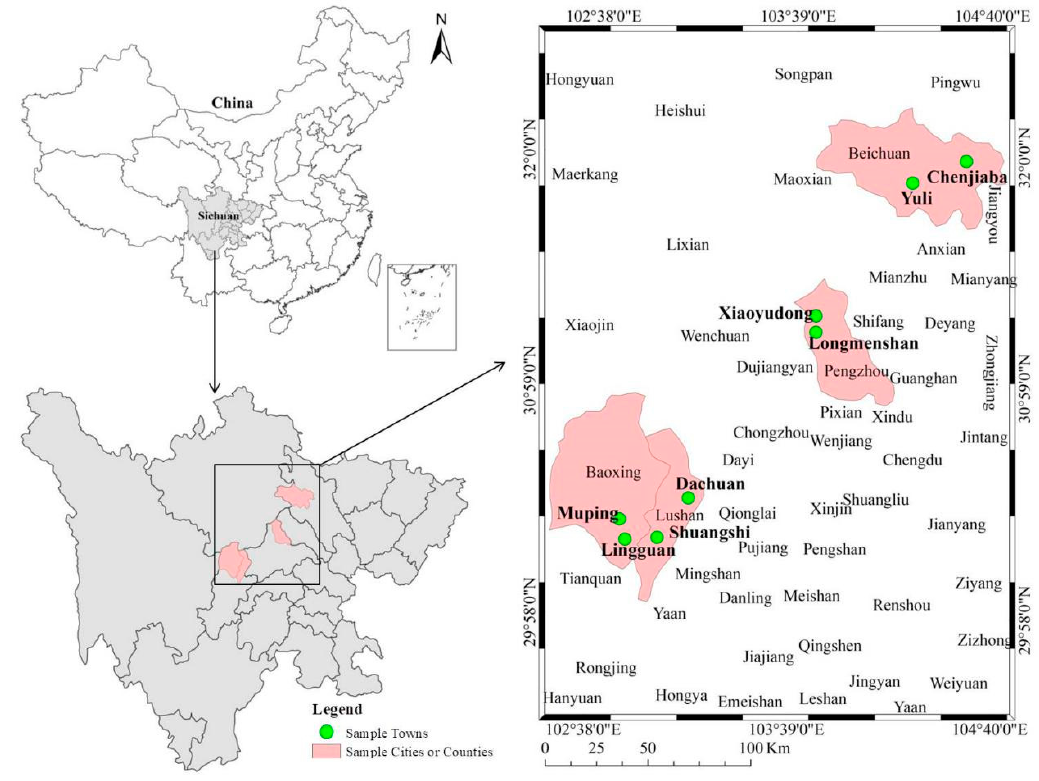
Figure 2. Distribution of sample villages.